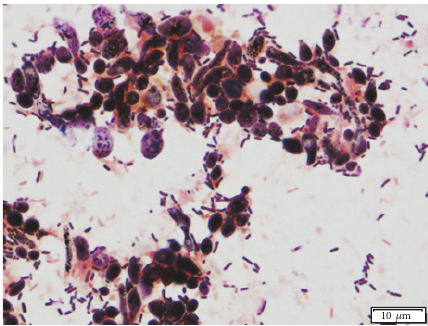
Figure 3: 1000x magnification of mixed bacteria and budding yeast like cells on Gram stain from a dog (case 3). Photo credit: Bente